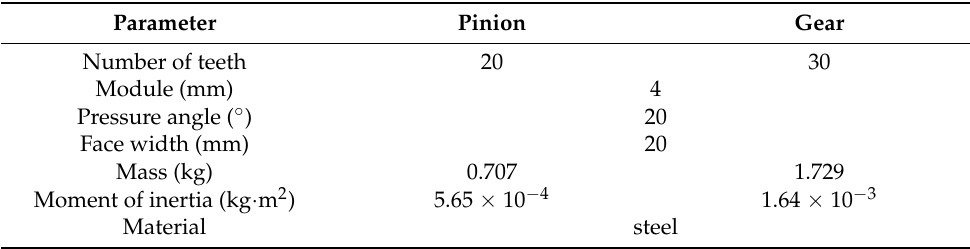
Table 1. Main parameters of the gear